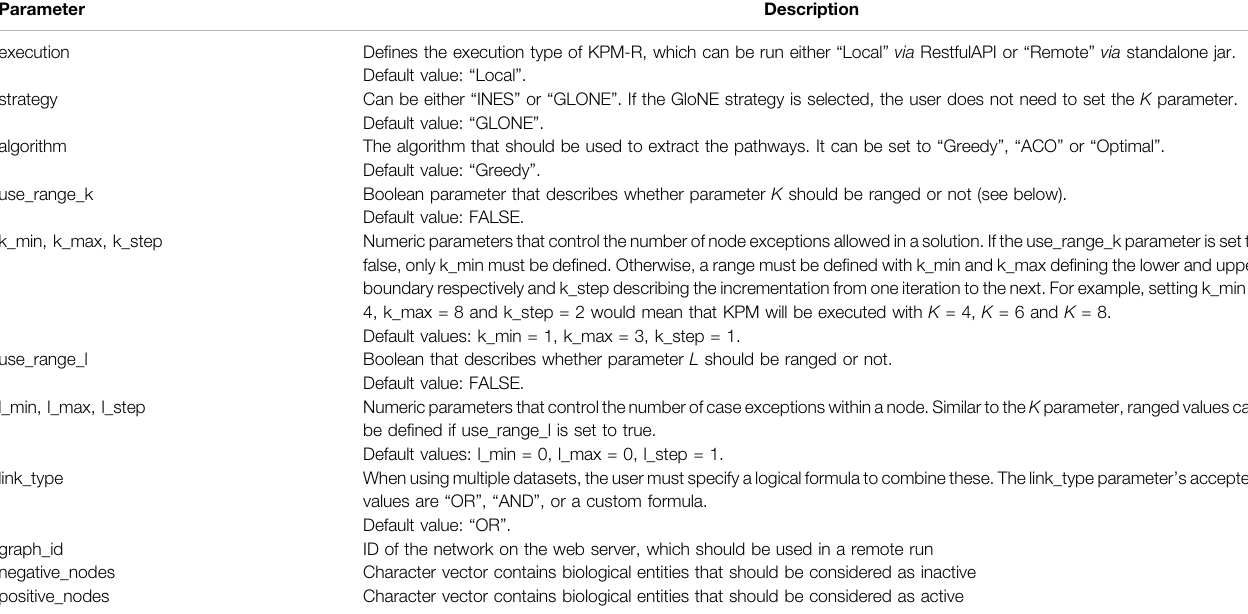
TABLE 1 | KPM run options and their description. Parameter